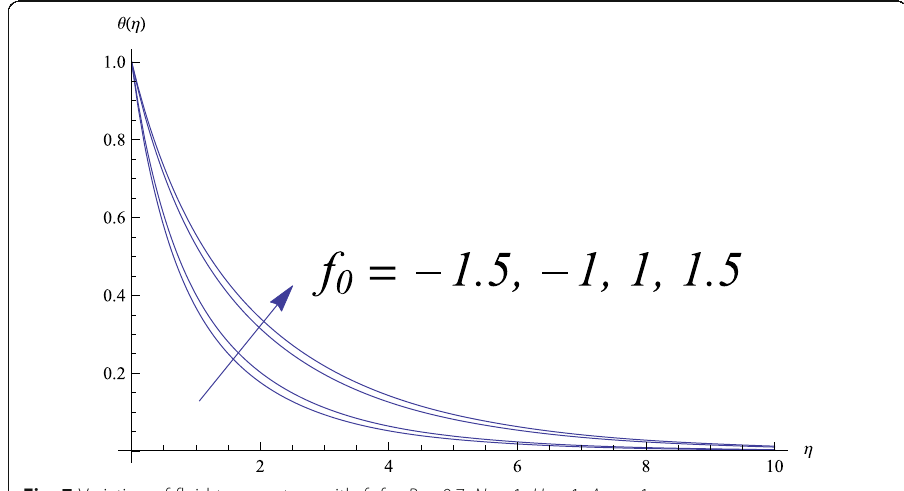
Fig. 7 Variation of fluid temperature with f 0 for Pr = 0.7, N R = 1, U 0 = 1, A = −